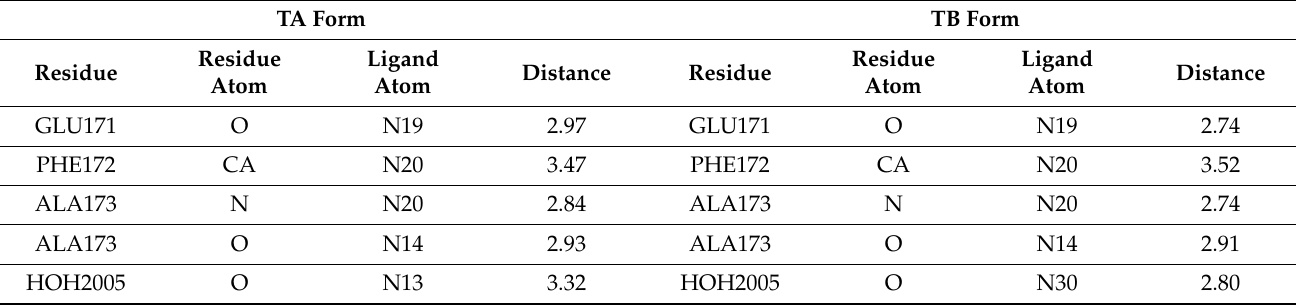
Figure 6. Representative examples to understand N_H_2B.